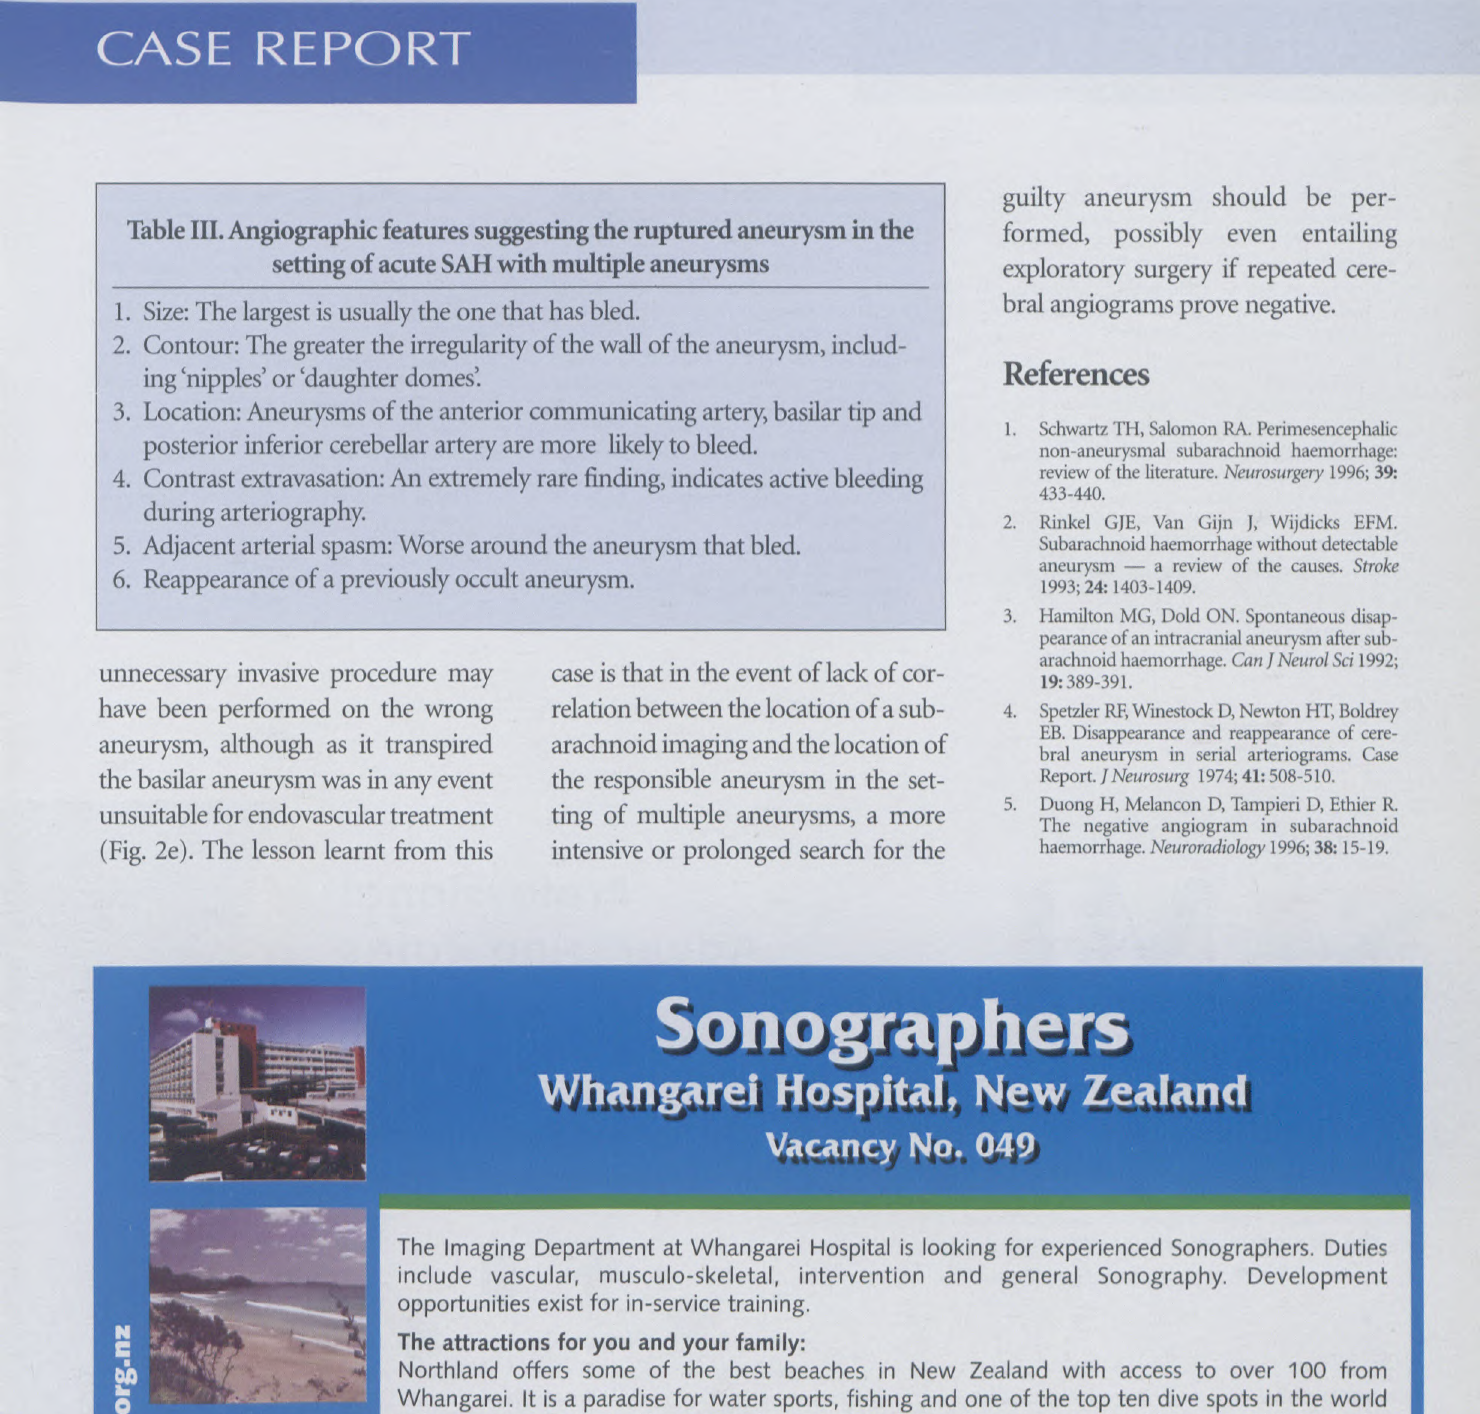
Table III. Anglographic features suggesting the ruptured aneurysm in the setting of acute SAH with multiple